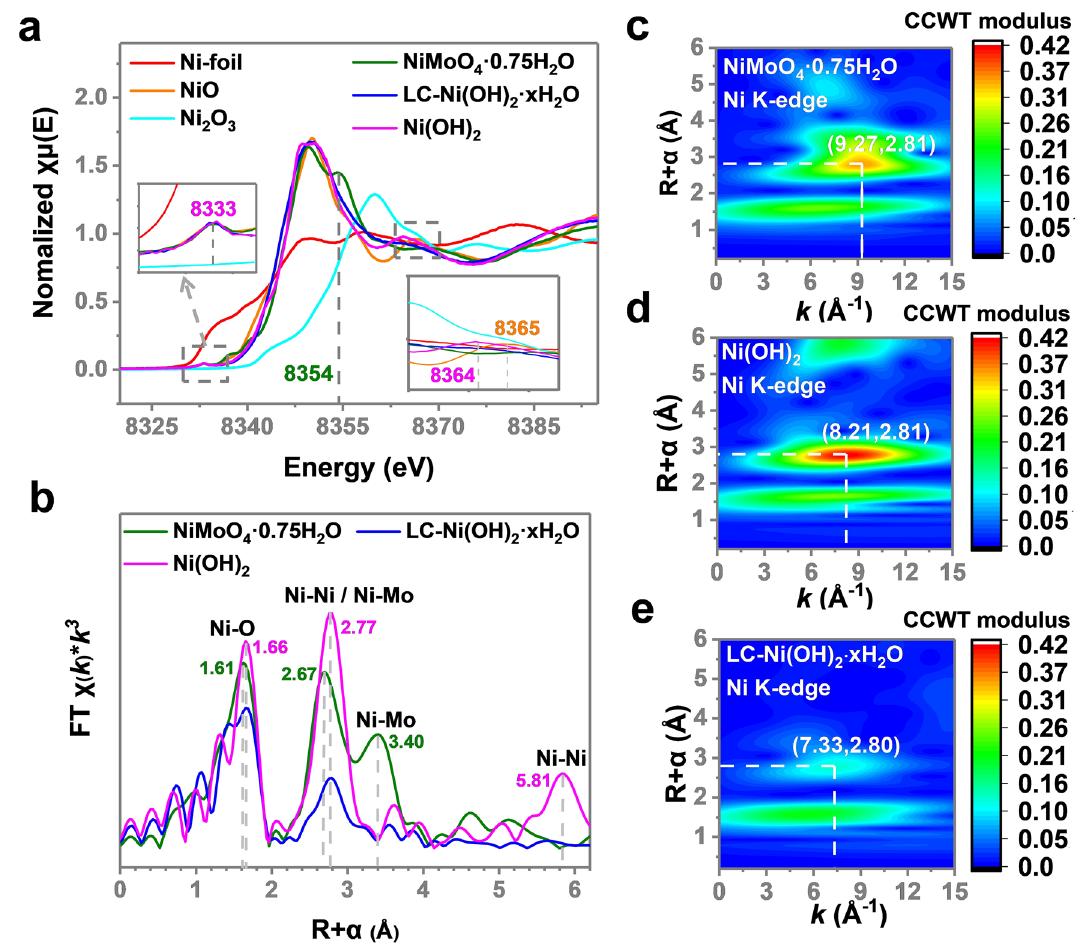
Fig. 4 a Ni K‑edge images of NiMoO 4 ·0.75H 2 O, LC–Ni(OH) 2 · x H 2 O, Ni(OH) 2 , Ni foil, NiO and Ni 2 O 3 . b Fourier transform EXAFS in R space and c–e wt‑EXAFS for